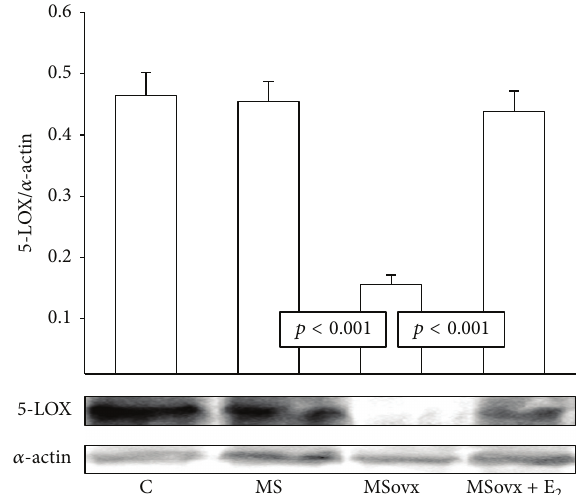
Figure4:DensitometricanalysisofWesternblotsfor5-LOXprotein expression in kidney homogenate in experimental groups. Data are means ± SE; 𝑛 = 7 in each group.